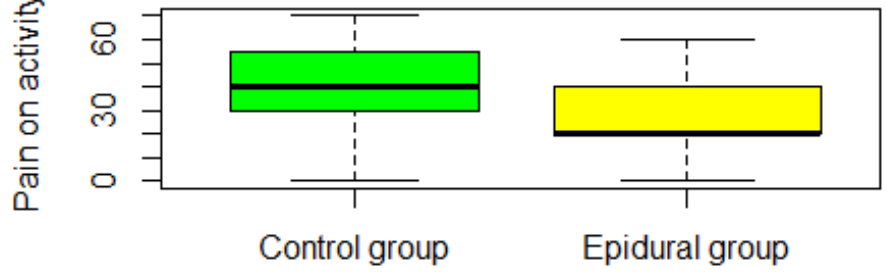
Figure 4. The VAS pain on activity was obtained at the end of the analgesia protocol.